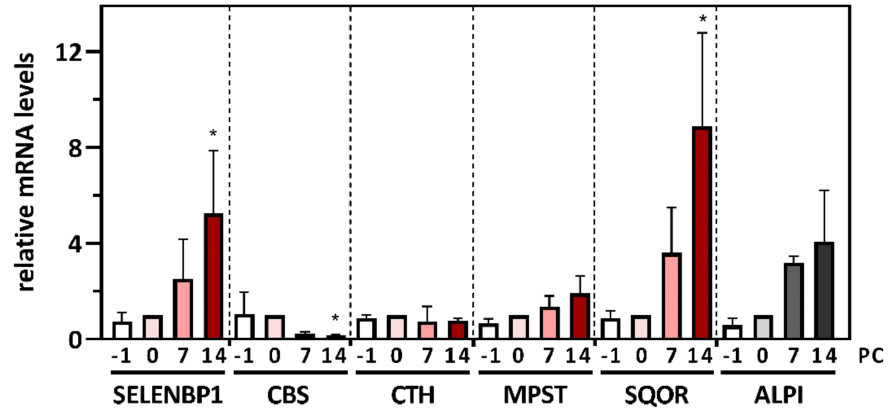
Figure 2. Alterations in the gene expression of H 2 S-modulating enzymes in the course of spontaneous (contact inhibition-induced) differentiation of Caco-2 cells to a colonocyte-like phenotype. Caco-2 cells were cultured for the indicated periods of time with respect to day 0, i.e., the day they reached confluence (PC, days post-confluence). Relative mRNA levels of SELENBP1, MPST, CBS, CTH and SQOR at different time points during spontaneous differentiation (as compared to the reference point PC 0) were determined by qRT-PCR, with normalization against the housekeeping gene RPLP0. Differentiation of the Caco-2 cells was substantiated by an increase in mRNA levels of ALPI. Three independent experiments were performed; the data represent means ± SD. Statistical analysis was done using the Friedman test and Dunn’s post-hoc test, with statistical significance at p < 0.05